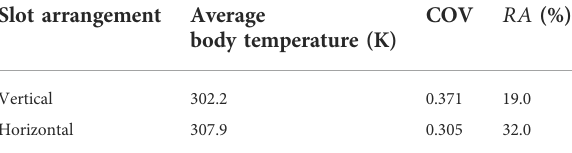
TABLE 2 Heating results of the vertical and horizontal slot